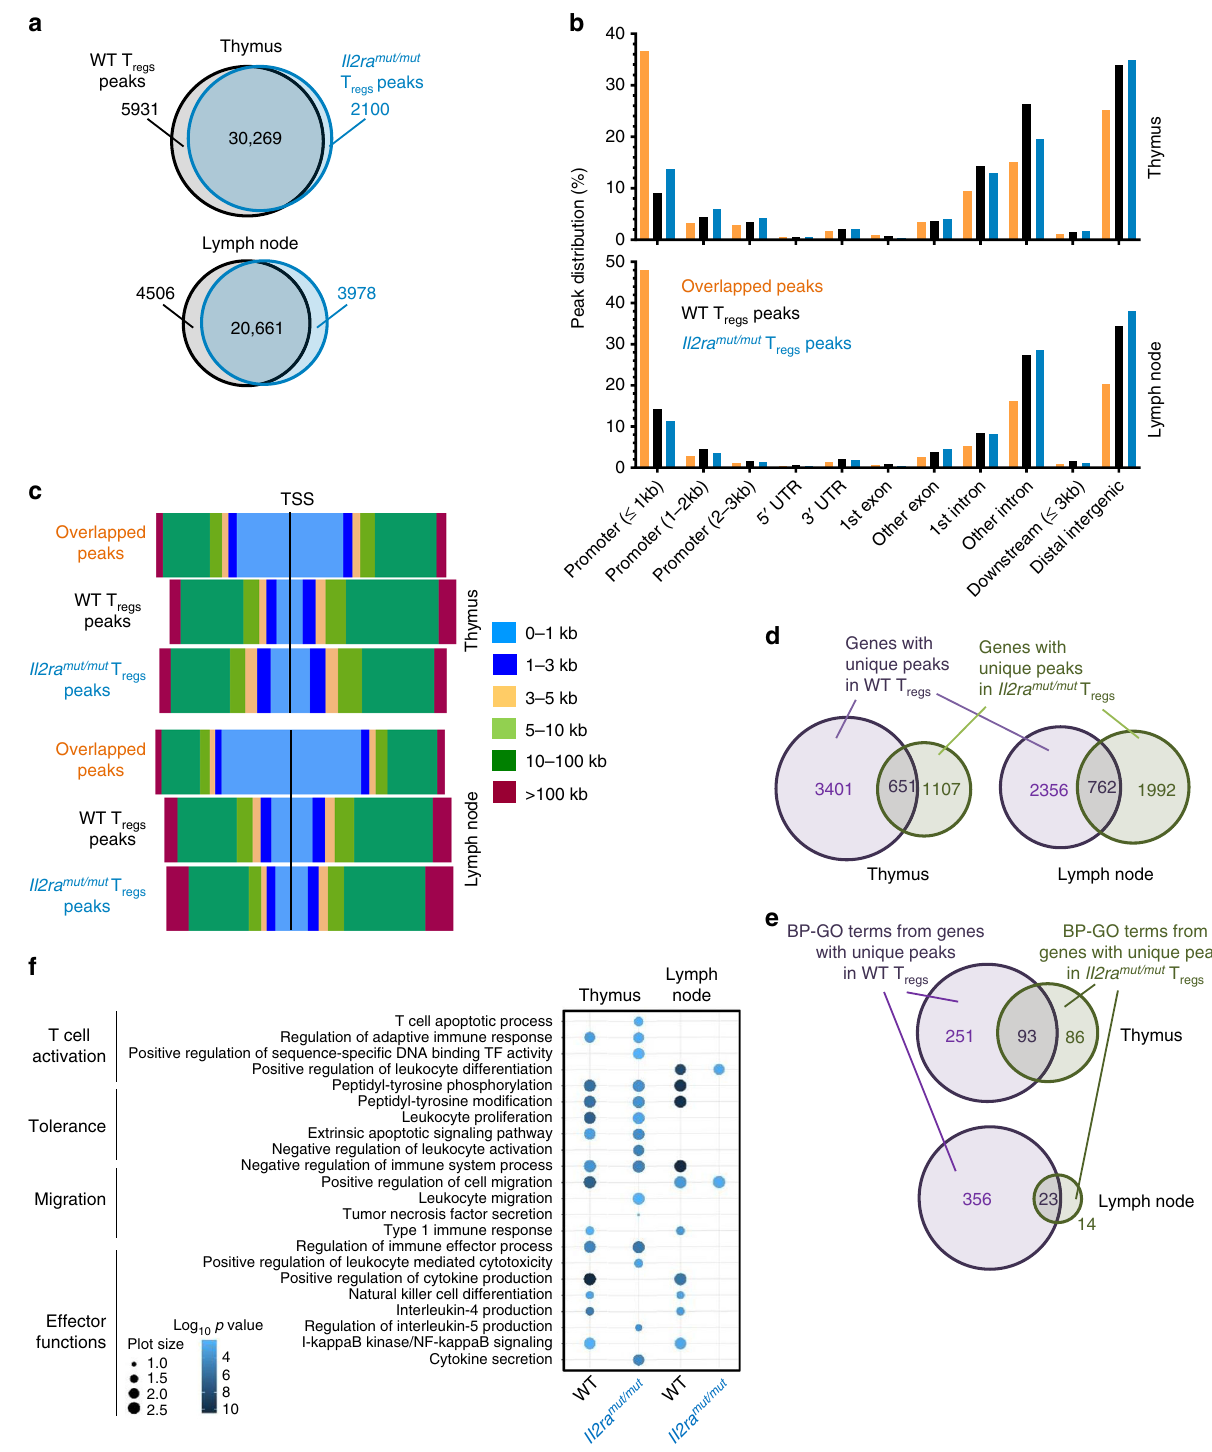
Fig. 3 IL-2 makes substantial modi fi cations in the epigenetic landscape of T reg cells: T reg cells (5 × 10 4 ) were sorted by fl ow cytometry from thymus or LNs of Il2ra mut/mut and WT Foxp3 Rfp/Rfp reporter mice, lysed and DNA from nucleus extracted for analysis of open chromatic regions by ATAC-seq. a Venn diagram of number of common and unique ATAC-seq peaks (OCRs) in Il2ra mut/mut vs WT T reg cells from thymus and LNs. b , c Distribution of common and unique ATAC-seq peaks across gene organization ( b ) and distance to the transcription start site (TSS, c ) in the whole genome. d , e Venn diagrams of number of genes ( d ) and GO pathways ( e ) exhibiting unique peaks in Il2ra mut/mut vs WT thymic and LN T reg cells on all ( d ) or within ( e ) 20 kb from TSS. f Network analysis of biological-process GO term enrichment among genes with unique peaks within 20 kb from TSS in Il2ra mut/mut or WT thymic and LN T reg cells. Genes were analyzed for over-represented GO terms using ReviGO. Node color is proportional to the FDR-adjusted p -value of the enrichment. Node size is proportional to gene set